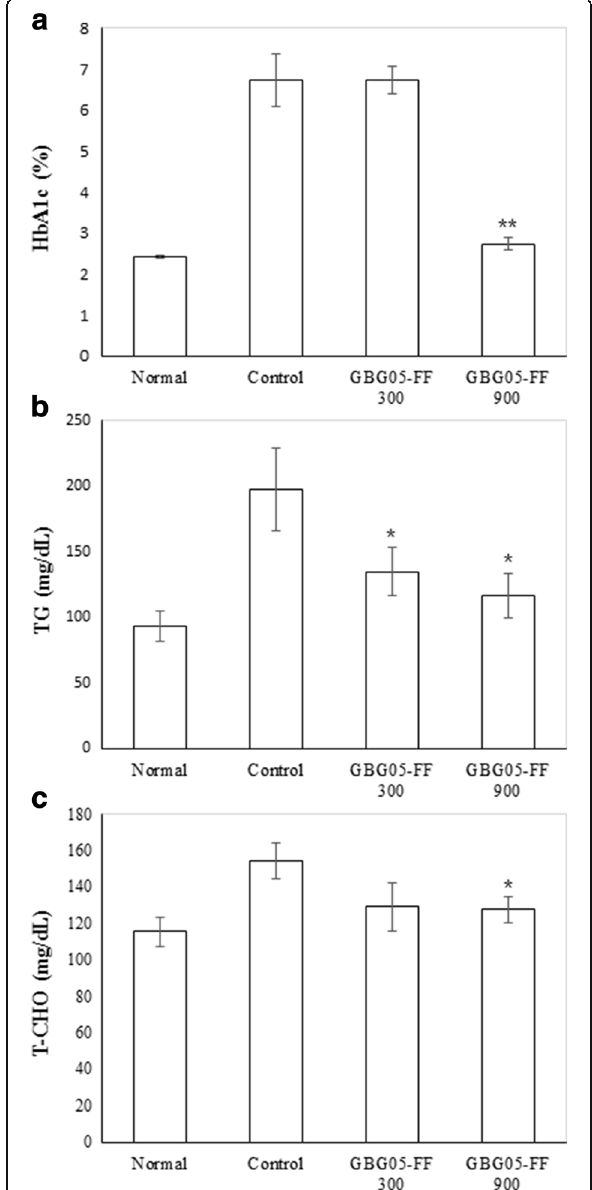
Fig. 3 Effect of GBG05-FF on Glycated hemoglobin ( a ), Triglyceride ( b ) and Total-cholesterol ( c ) in blood serum of mice. Normal: dbh, Control: db/db, GBG05-FF 300: db/db fed the GBG05-FF 300 mg/kg, and GBG05-FF 900: db/db fed the GBG05-FF 900 mg/kg. Each value represents the mean ± SEM ( n = 10 per group). * P < 0.05, ** P < 0.01: Significant difference vs. control